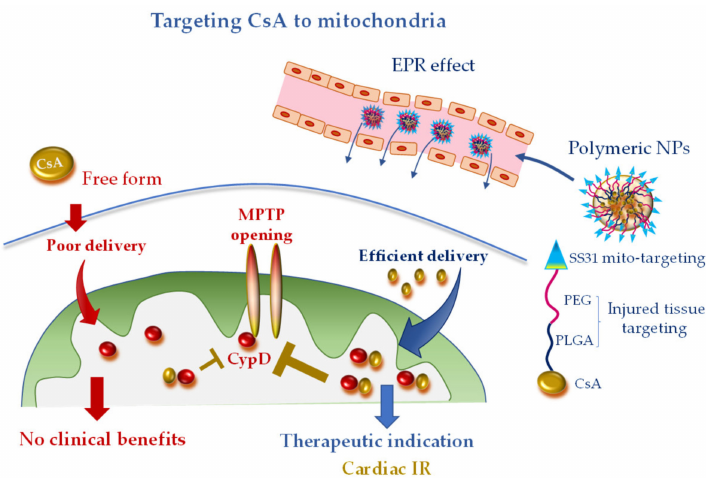
Figure 3. Mitochondria-targeted delivery of cyclosporine A (CsA) in free form versus nanoparticle (NP) formulation. Free CsA su ff ers of poor delivery at the injured tissue, which might have undermined clinical benefit. NP formulation, with tissue injury targeting moieties (polyethylene glycol (PEG) and poly(lactic-co-glycolic) acid (PLGA)) and mitochondriotropic SS31 moiety, is anticipated to confer promising therapeutic e ffi cacy, especially in acute ischemic CVD. CydD, cyclophillin D; EPR, enhanced permeability and retention; IR, ischemia and reperfusion; MTPT, mitochondrial permeability transition pore; PEG, polyethylene glycol; PLGA,